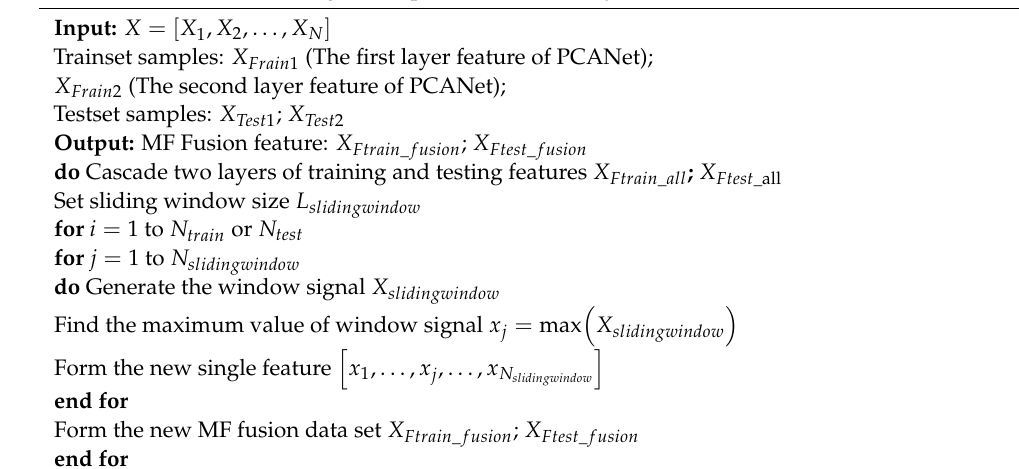
Algorithm 1. MaxFusion algorithm procedure of two layers PCANet